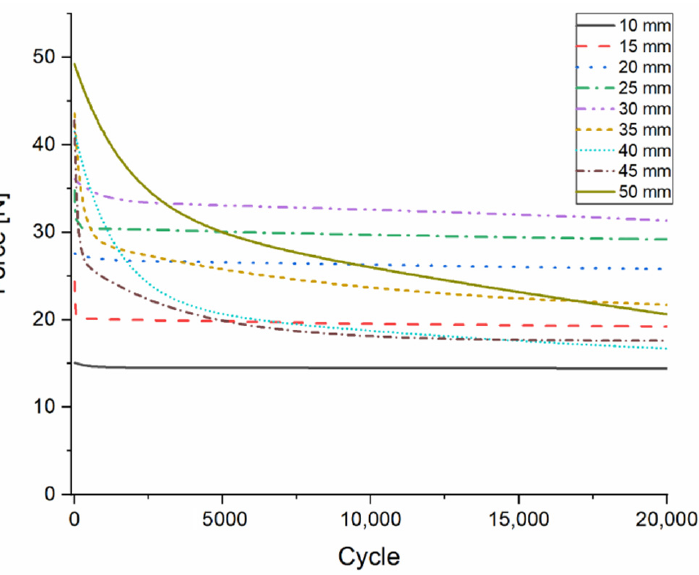
Figure 6. Results of the flexural fatigue test of the composite material. Force values measured at each deflection rate. The colored lines indicate the change in the force values (N), measured up to 200,000 cycles.